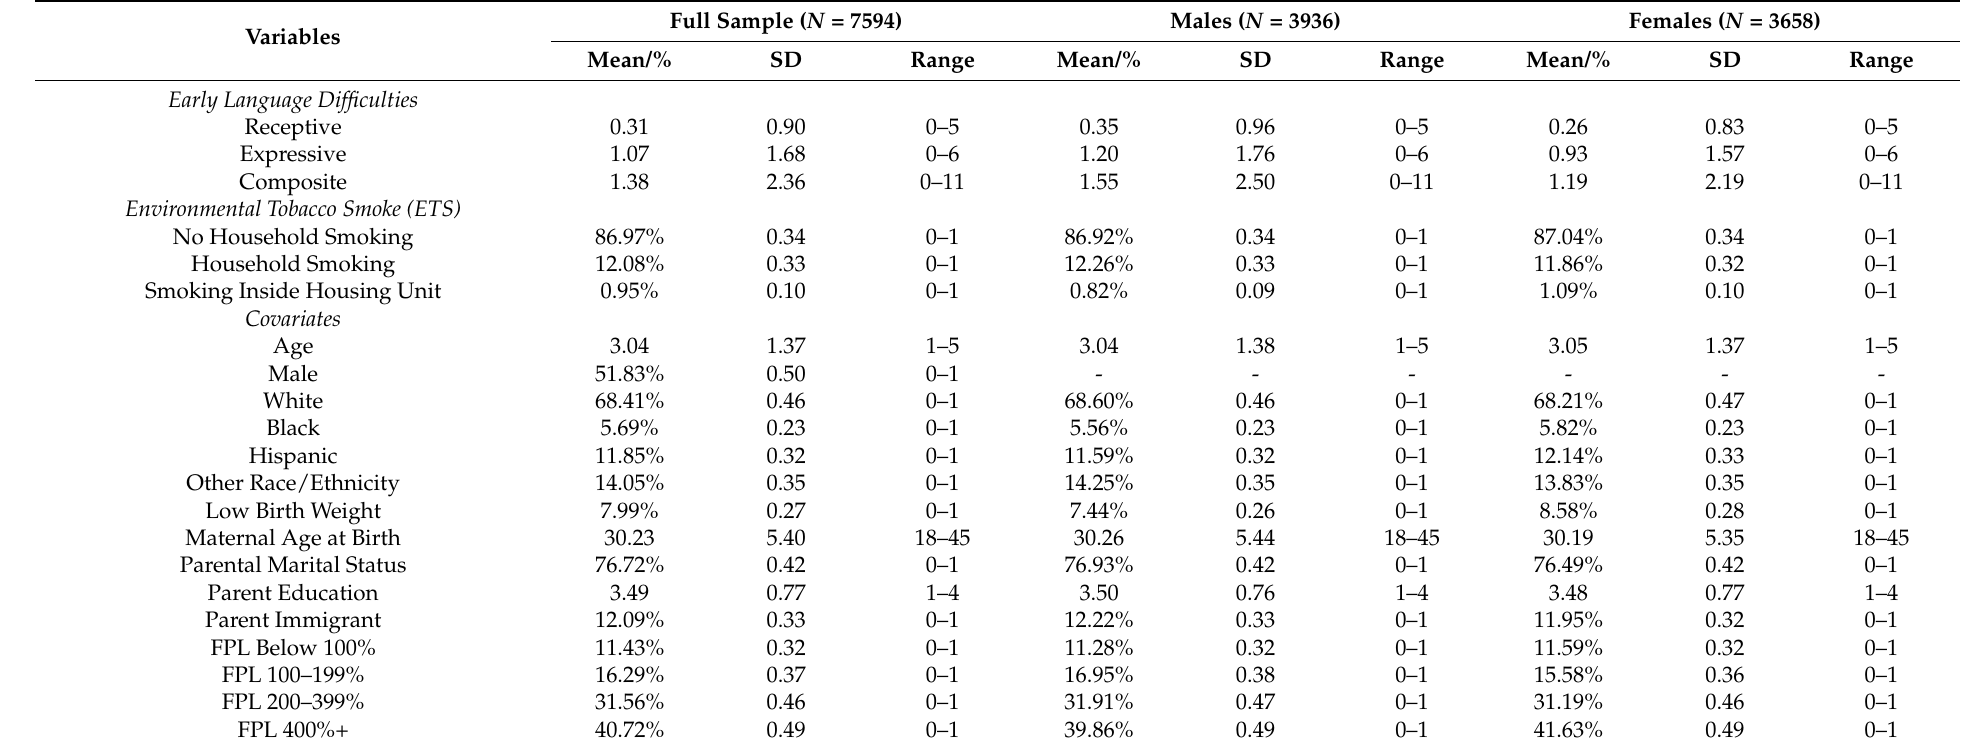
Table 1. Descriptive statistics pertaining to children aged 1 to 5, stratified by child